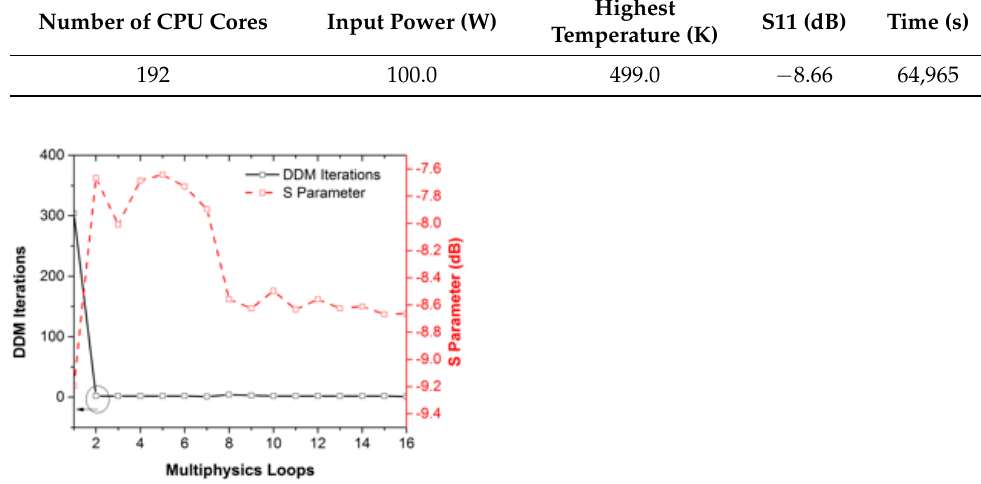
Figure 10. DDM iteration step change and S parameter change during the multiphysics simula- tion. Table 3. Information of antenna array multiphysics simulation.